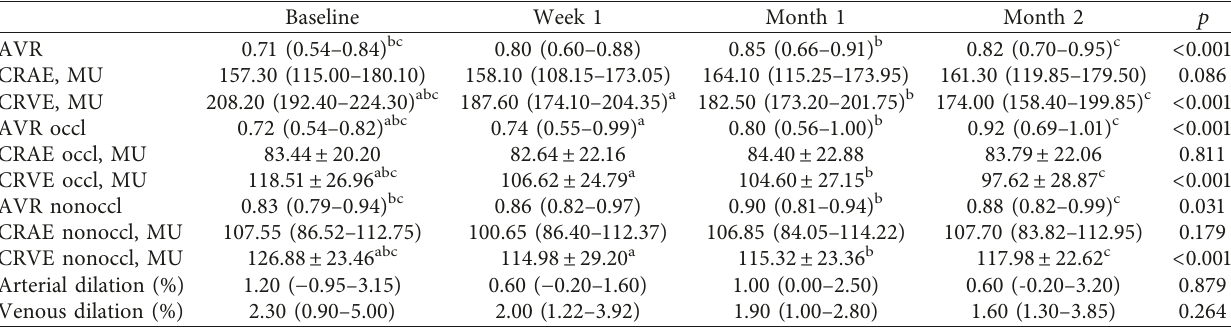
AVR � arteriovenous ratio; AVR nonoccl � arteriovenous ratio in nonoccluded quadrants of RVO and corresponding quadrants of controls; AVR occl � arteriovenous ratio in occluded quadrants of RVO and corresponding quadrants of controls; CRAE � central retinal artery equivalent; CRAE nonoccl � central retinal artery equivalent in nonoccluded quadrants of RVO and corresponding quadrants of controls; CRAE occl � central retinal artery equivalent in occluded quadrants of RVO and corresponding quadrants of controls; CRVE � central retinal vein equivalent; CRVE nonoccl � central retinal vein equivalent in nonoccluded quadrants of RVO and corresponding quadrants of controls; CRVE occl � central retinal vein equivalent in occluded quadrantsof RVO and correspondingquadrantsof controls; MU � measurement units;values areexpressed as mean ± standard deviationand median